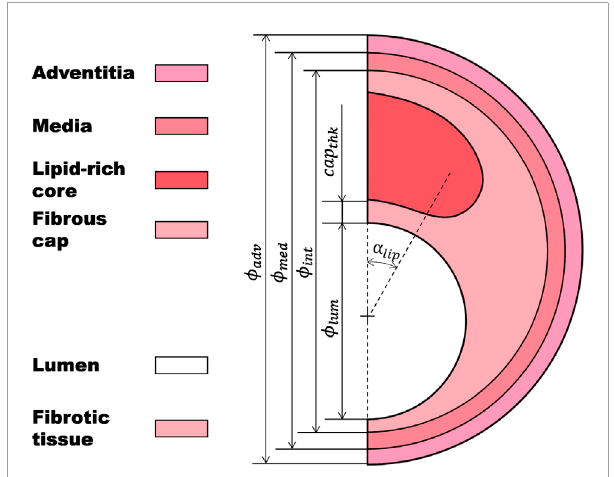
FIGURE 1 Idealized atherosclerotic coronary artery including lipid-rich core, fibrotic tissue, fibrous cap, tunica media, and tunica